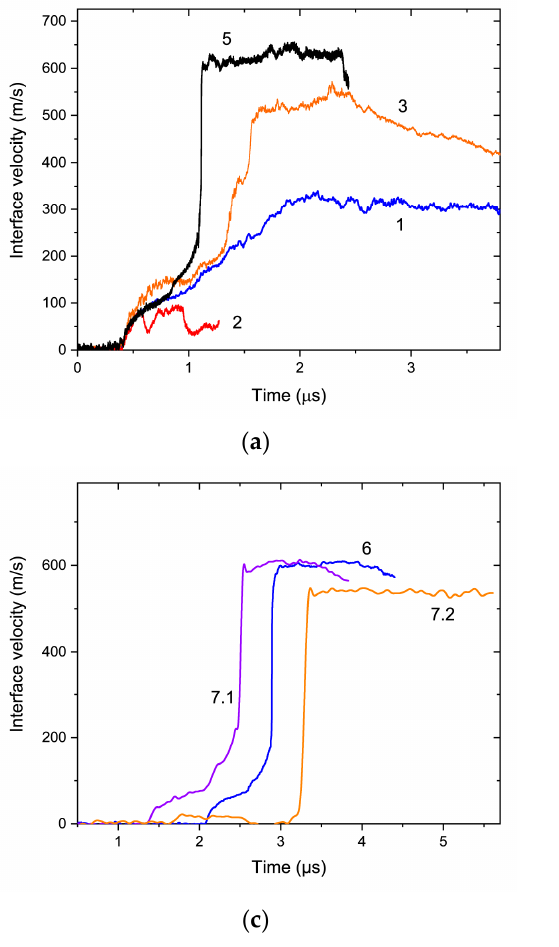
Figure 3. Measured velocity profiles. The numbers correspond to the experiment numeration (see Tables 1–3). ( a ) Experiments 1–3, 5 were conducted with the nearly same sample thickness, but different impact velocities. The water windows were used in Experiments 1, 3, 5; the LiF window was used in Experiment 2 (only the precursor trace was available). Time t = 0 was arbitrary, the profiles were adjusted to coincide in the precursor fronts. ( b ) Experiments 3 and 4 were performed with different sample thicknesses and the nearly same impact velocity. Time t = 0 was arbitrary, the profiles were adjusted to coincide in precursor fronts. ( c ) Experiments 6, 7.1, and 7.2 were conducted with the same impact velocity, but different sample thickness as the windows were water (Experiments 6, 7.1) and LiF (Experiment 7.2). Time t = 0 was the time of impact. ( d ) The sample thickness and impact velocity were the same as in the Experiment 8 set, but the windows were different; the same applied to set 9. Time t = 0 was the time of impact.